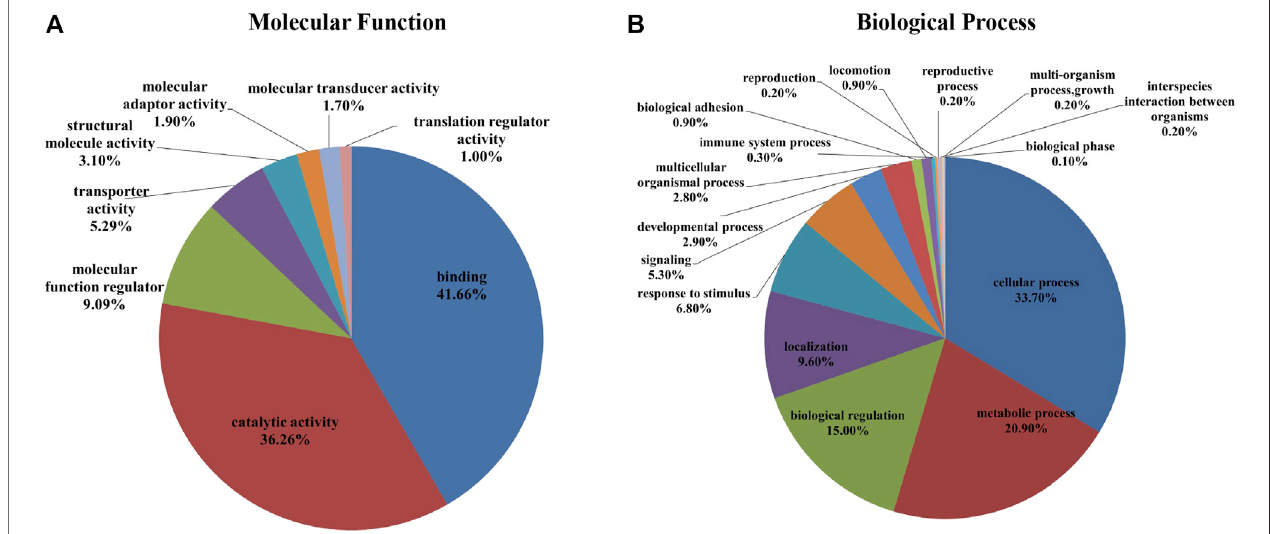
FIGURE 4 | A total of 1,695 identi fi ed proteins (1,545 gene names) were annotated using the PANTHER ™ Classi fi cation System according to their molecular function (A) and biological process (B) .